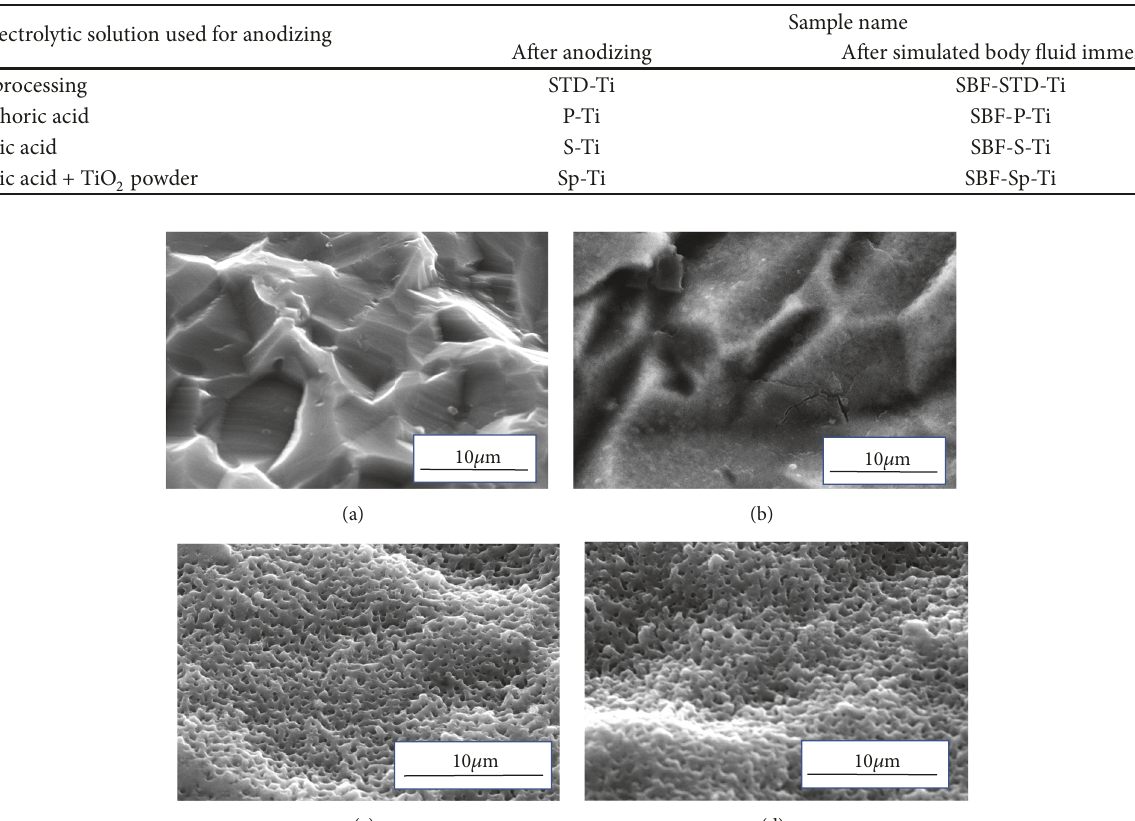
measured with a spectrophotometer (U-5100, HITACHI) every 10 min, and the concentration of Mb was determined from the calibration